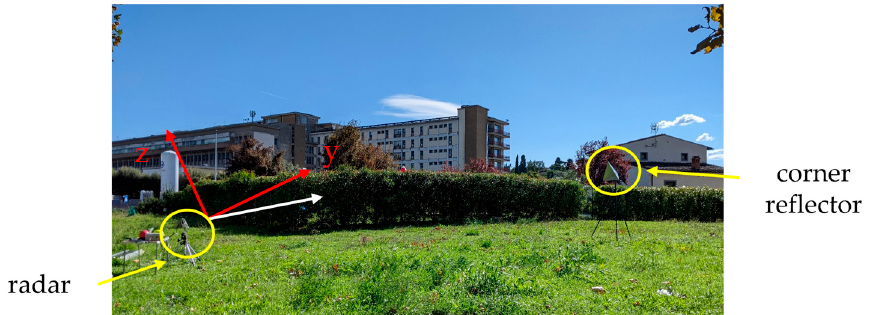
Figure 7. Measurement setup for the tests in controlled scenario with a single corner reflector. As the